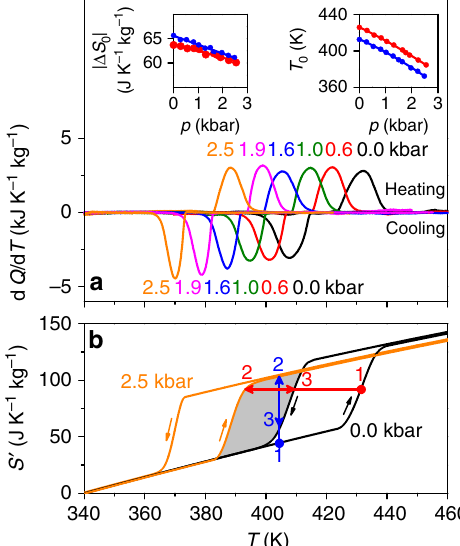
Fig. 1 Superionic transition in AgI under pressure. a Heat fl ow d Q /d T on heating and cooling through the transition at different values of increasing pressure p , after baseline subtraction. At pressure p , we show (left inset) the thermally driven entropy change | Δ S 0 | and (right inset) transition temperature T 0 , on heating (red) and cooling (blue) (lines denote fi ts). b Entropy S ′ ( T , p ), constructed by plotting S ′ ( T ) at p ~ 0 and 2.5 kbar, on heating and cooling as indicated via arrows ( S ′ denotes entropy with respect to absolute entropy at 340 K and p ~ 0). Adiabatic (isothermal) trajectories in red (blue) are irreversible (1 → 2), or reversible (2 ↔ 3) if wholly within the reversibility region